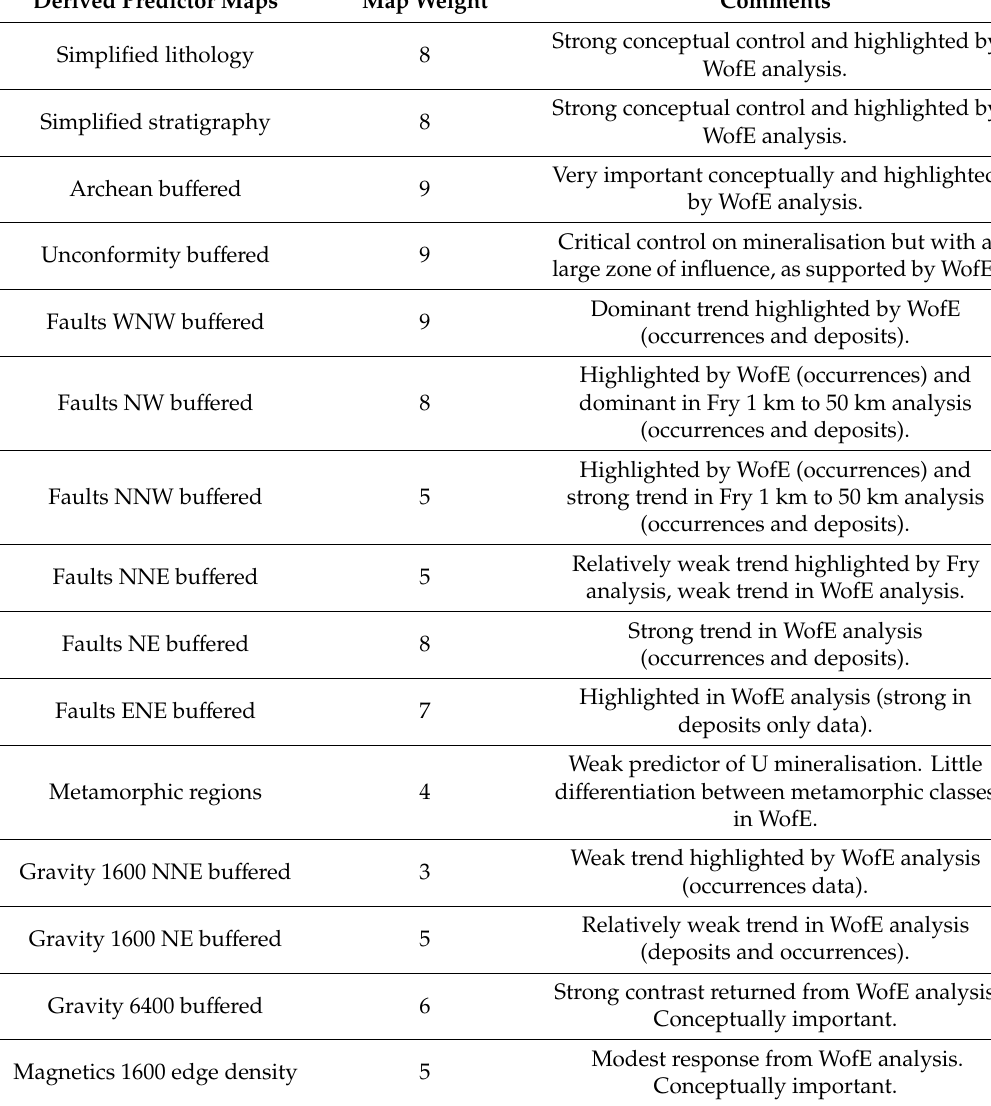
Table 6. NW McArthur Basin MPM map weights. Weights reflect the perceived importance of the recognition criteria in the mineralisation model and / or greater confidence in the data from which the layer was derived. Full details, including class weights are provided in Appendix